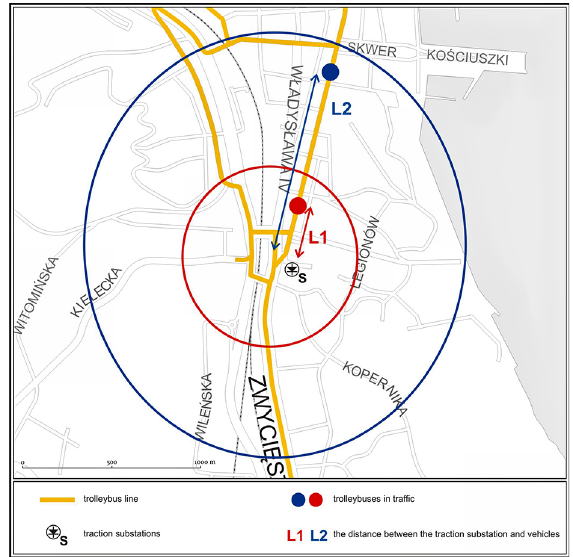
Fig. 7. An illustration of the effect of the size of the power supply area of the substation for electricity transmission losses – any increase in the size of the power supply area leads to an increase in the distances between the vehicles from the substation ( L 1 > L 2 ), and consequently, an increase in transmission losses